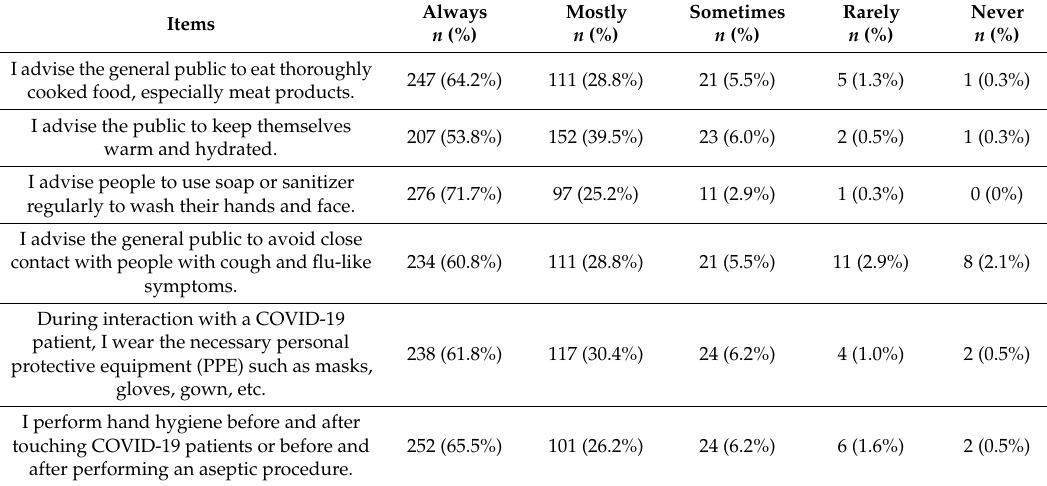
Table 4. COVID-19 related practices and risk